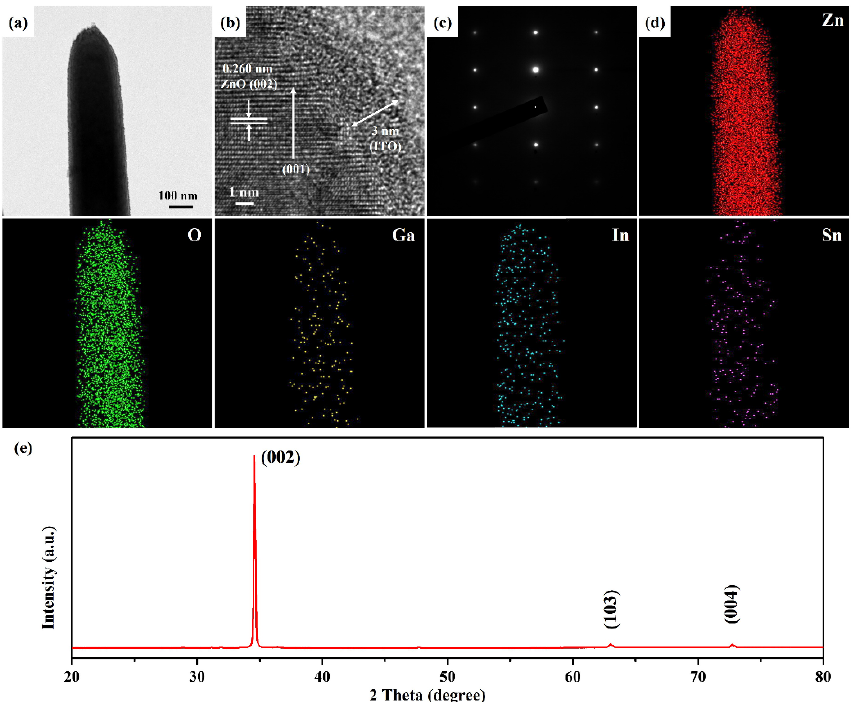
Figure 3. ( a ) FETEM, ( b ) HRTEM, ( c ) SAED pattern, and ( d ) EDS mapping images of a ZnO: